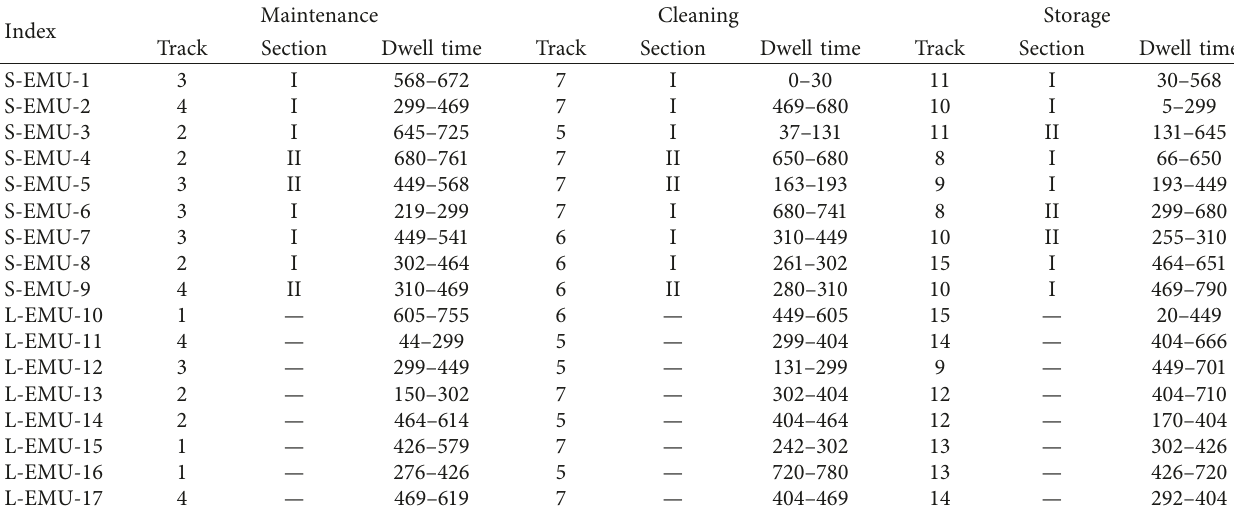
Table 4: The shunting operation plan generated by CPLEX at the through EMU